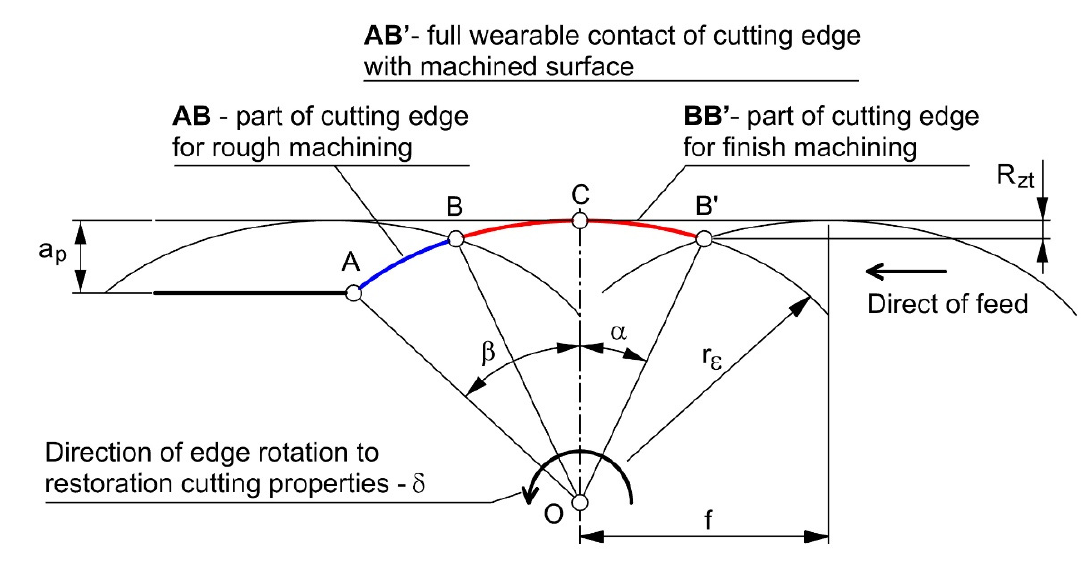
Figure 1. Presentation of contact conditions between the cutting edge and workpiece surface. Based on analysis of Equation (2), we can see that angle α depends on feed f and radius of insert r ε . From the analysis of Equation (3), we can observe that the β value depends on a p and r ε . Round inserts are produced in a wide range of diameters. For example, Sandvik Coromant produces round inserts: T-Max ® P system RCMX type (cylindrical–Figure 2a) for 10, 12, 16, 20, 26, 32 mm diameter; and the CoroTurn ® 107 sys- tem RCMT-type (cone shape—Figure 2b) for 05, 06, 08, 10, 12, 16, 20, 25, 32 mm diameter. Based on the practical range of insert dimensions used, graphs showing the effect of the radius of insert rand feed f on angle α (Figure 3) and a p on angle β (Figure 4) were drawn. The in-depth SEWCE analysis of the phenomenon, based on the existing solutions for the diameters used, as shown in Figures 3 and 4 and the following figures, represents a significant advance compared with our previous work [28].